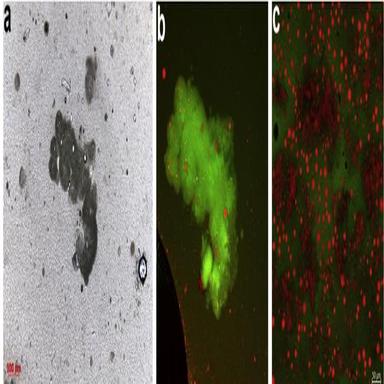
Light micrograph (a) and confocal micrograph (b) of isolated bulk particles. Confocal micrograph of the surface of reconstituted milk (c). Protein stained green and fat stained red in confocal micrographs.